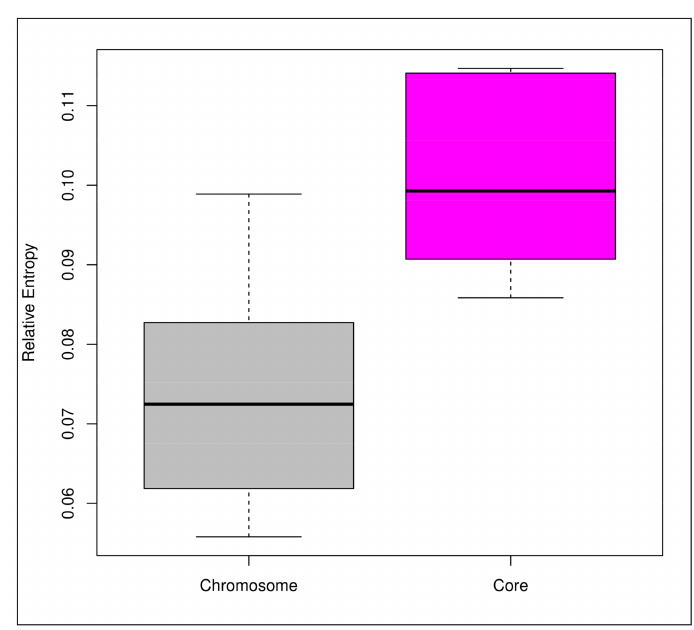
Figure 2. The relative entropy of chromosome versus core-genome for the 56 PHBifs. The relative entropy depicts the magnitude of the selection pressure. The core part has a higher selection pressure than that of the chromosome. Significant differences between the two groups were tested with the Welch’s t -test ( p -value < 0.001).